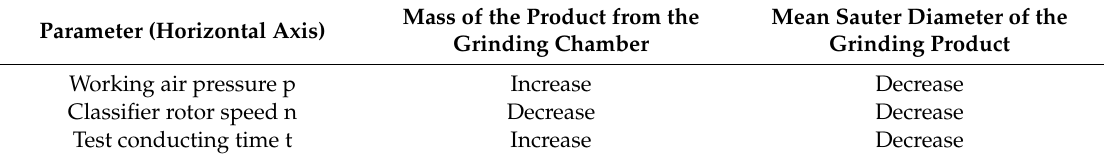
Table 5. E ff ect of an increase in input parameters on mass of the grinding product and the mean Sauter diameter of the grinding product from fluidized bed jet